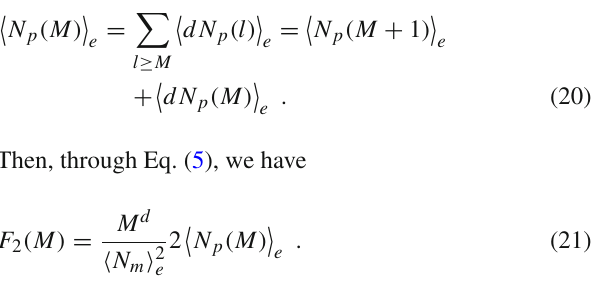
Fig. 2 a Two points at distance R form a pair that fits in a ring of radius ∼ R centred at one of the points. b Here each pair of points is represented by one point, the one that is not positioned at the centre of the ring or disk, so, the dots represent pairs. The ring or disks appearing in this figure represent all similar rings or disks of equal size formed